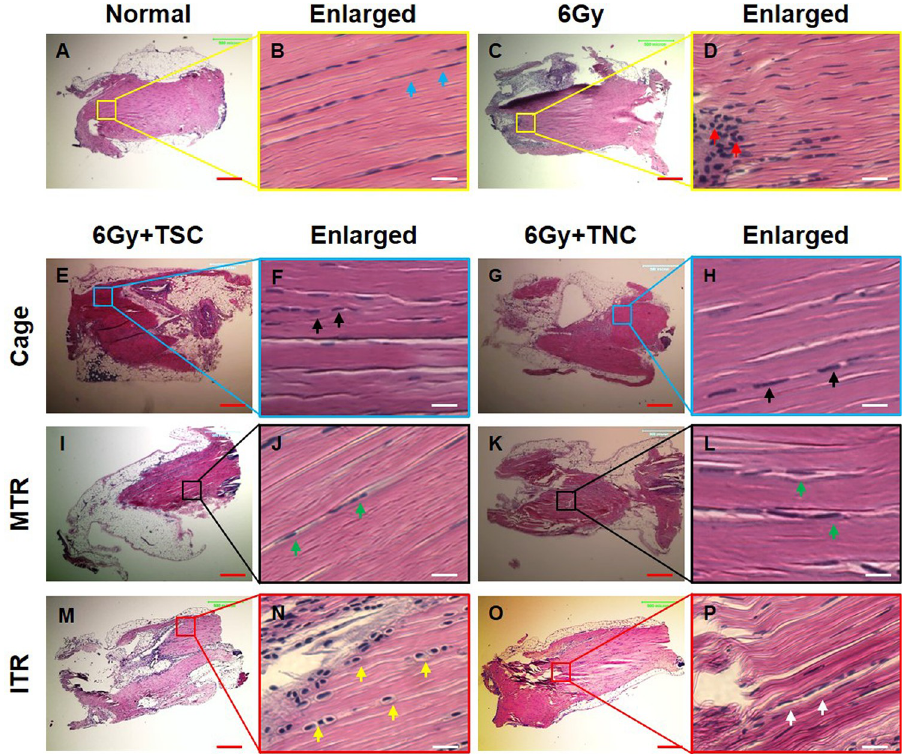
Fig 4. Cell morphological changes in tendon tissue sections after irradiation, injection, and treadmill running. The H&E staining results show that normal cells ( A, B ) maintain the elongated shape (blue arrows in B ) and irradiated cells ( C, D ) increase in density (red arrows in D ). The cells either in TSCs injected tissues ( E, F ) or in TNCs injected tissues ( G, H ) do not change the shape in cage control condition (black arrows in F, H ). Also, the cells either in TSCs injected tissues ( I, J ) or in TNCs injected tissues ( K, L ) do not change the shape after MTR (green arrows in J, L ). However, the cells in tendon tissues injected with GFP-TSCs ( M, N ) assume a round shape (yellow arrows in N ) after ITR. In contrast, the cells in TNCs-injected tissues ( O, P ) do not change shape (white arrows in P ) after ITR. The images in the second and fourth columns are enlarged images of the boxes in the first and third columns, respectively. Red bars: 500 μ m; white bars: 25 μ m. MTR: 13 m/min, 50 min/day, 5 days a week for 3 weeks after a week’s training; ITR: 13 m/min, 3 hrs, 4 hrs, and 5 hrs/day in the 2 nd , 3 rd , and 4 th week respectively after a week’s training. N = 6 untreated control mice were utilized in A, B , and n = 3 irradiation mice were utilized in C, D . For irradiated cage, MTR, and ITR mice, n = 3 mice (6 tendons) with GFP-TSCs, and n = 3 mice (6 tendons) with GFP-TNCs for each group were